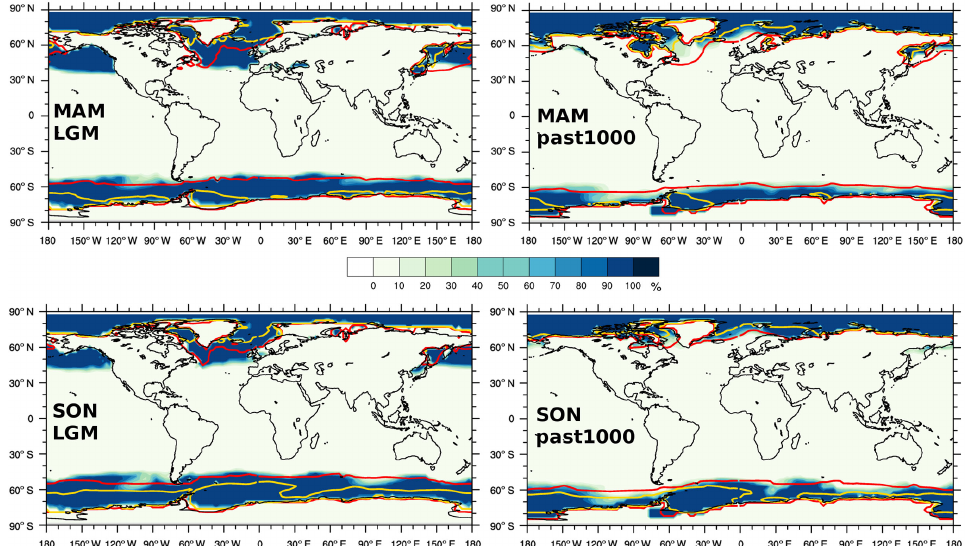
Figure 3. Maps of sea ice concentration averaged over all PlaSim ensemble members for indicated seasons and periods. The CMIP5 multi- model maximum extents denoted by the 15% concentration line are plotted for corresponding seasons and experiments with the red lines. The CMIP5 multi-model minimum extents are plotted with the yellow